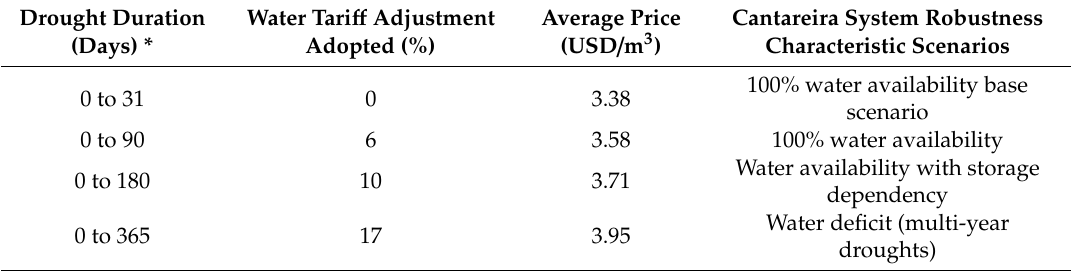
Table 3. Main assumptions for establishing tari ff water price according to drought